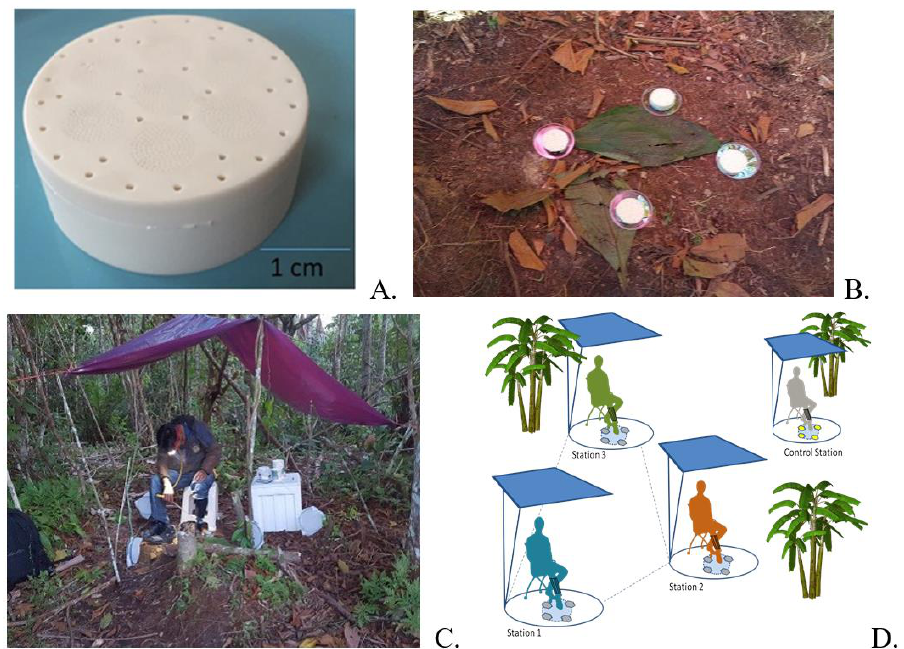
Figure 1. Experimental Setup. ( A ) CRDs. ( B ) Array of CRDs. ( C ) Collection station showing an example of a protected Human Landing Collection. ( D ) Collection Site Block Design.